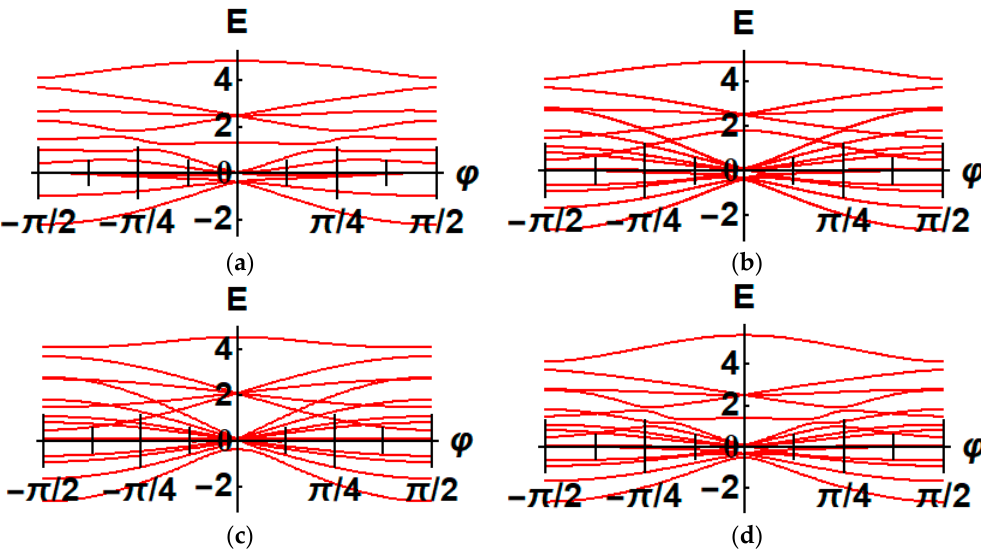
Figure 4. Energy spectrum of four spins in a chain and a second spin interacting with the quantized electromagnetic field. The number of excitations is equal to two. ( a ) Spin chain consist of spins 1/2; ( b ) Spin chain consists of spin 1, G 1 = cos ( ϕ ) and G 2 = 0; ( c ) Spin chain consists of spin 1, G 1 = 0 and G 2 = cos 2 ( ϕ ) ; ( d ) Spin chain consists of spin 1, G 1 = cos ( ϕ ) and G 2 = cos 2 ( ϕ ) .